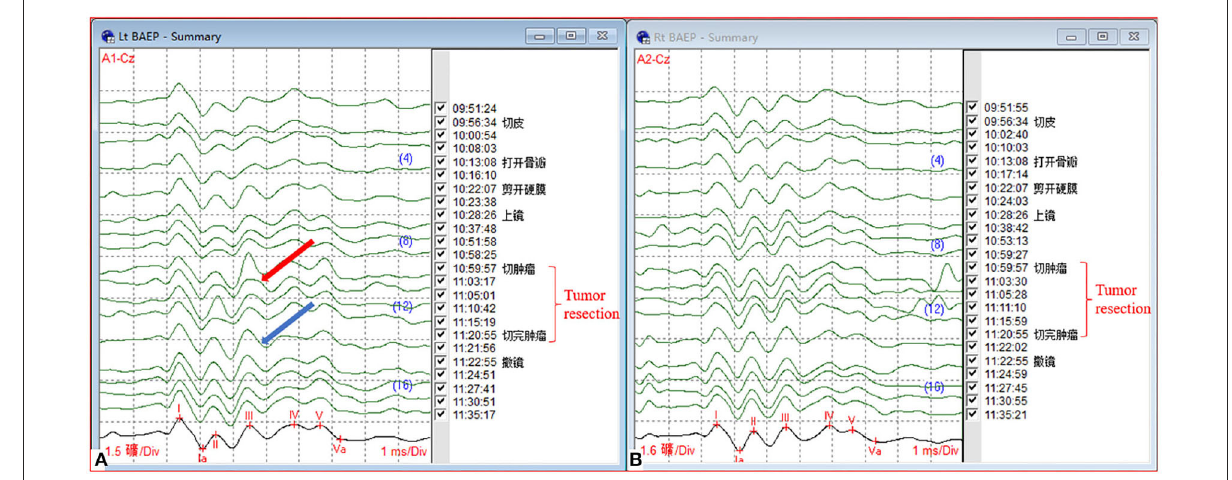
FIGURE8 Graph of intraoperative electrophysiological records of brainstem auditory-evoked potentials (BAEP). (A) Left BAEP. Red arrow: at the beginning of a tumor resection, the amplitude decreases; Blue Arrow: at the end of a tumor resection, the amplitude recovers. (B) Right BAEP.